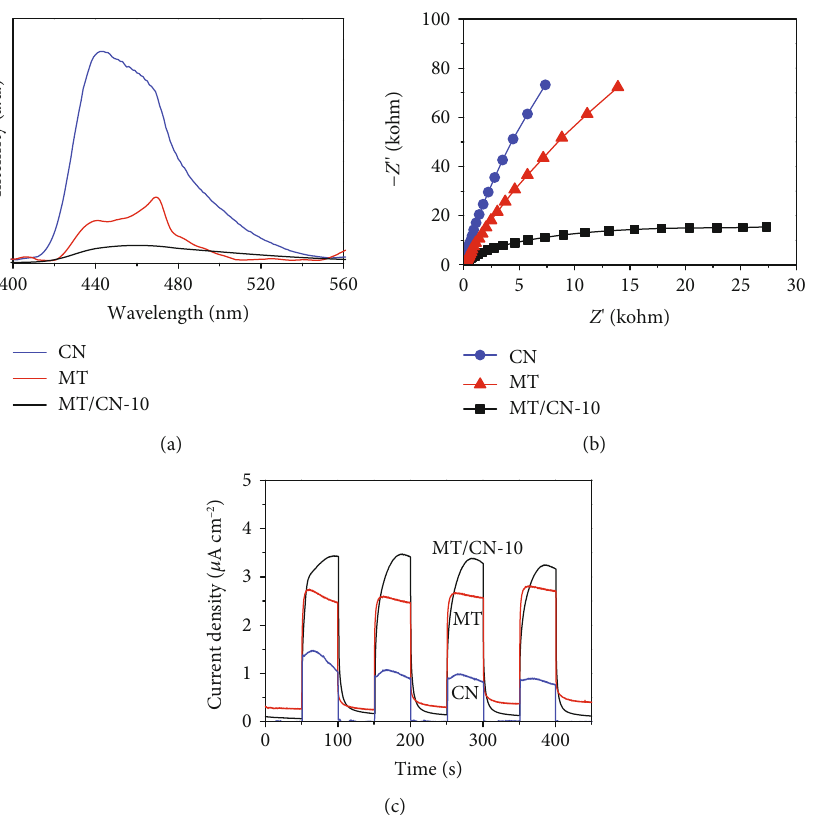
Figure 7: (a) Steady-state photoluminescence spectrum (PL) of samples (excitation wavelength of 325 nm). (b) Nyquist plots of electrochemical impedance spectra (EIS) for samples. (c) Transient photocurrent-time pro fi les for